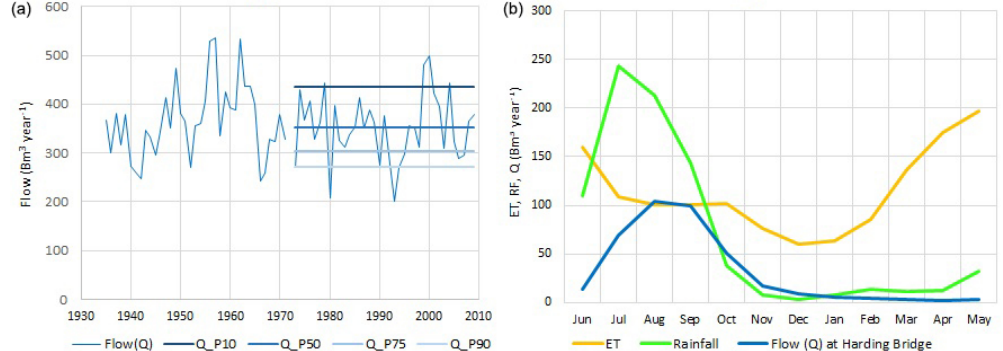
Figure 3. (a) River flow ( Q ) at Harding Bridge, and (b) average monthly ET, rainfall (RF), and river flow ( Q ) at Harding Bridge between 1998 and 2008. Sources: rainfall (Indian Meteorological Department), ET (University of East Anglia, Climatic Research Unit, Norwich, UK, 2014), and river flow (Institute of Water Modelling, Dhaka, Bangladesh).